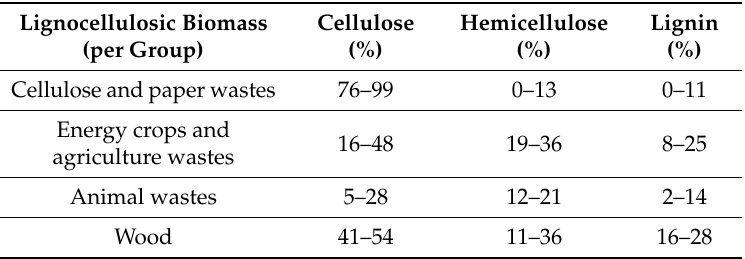
Table 1. Average composition of the main lignocellulosic biomass (LB) categories (expressed as percentage in dry basis).